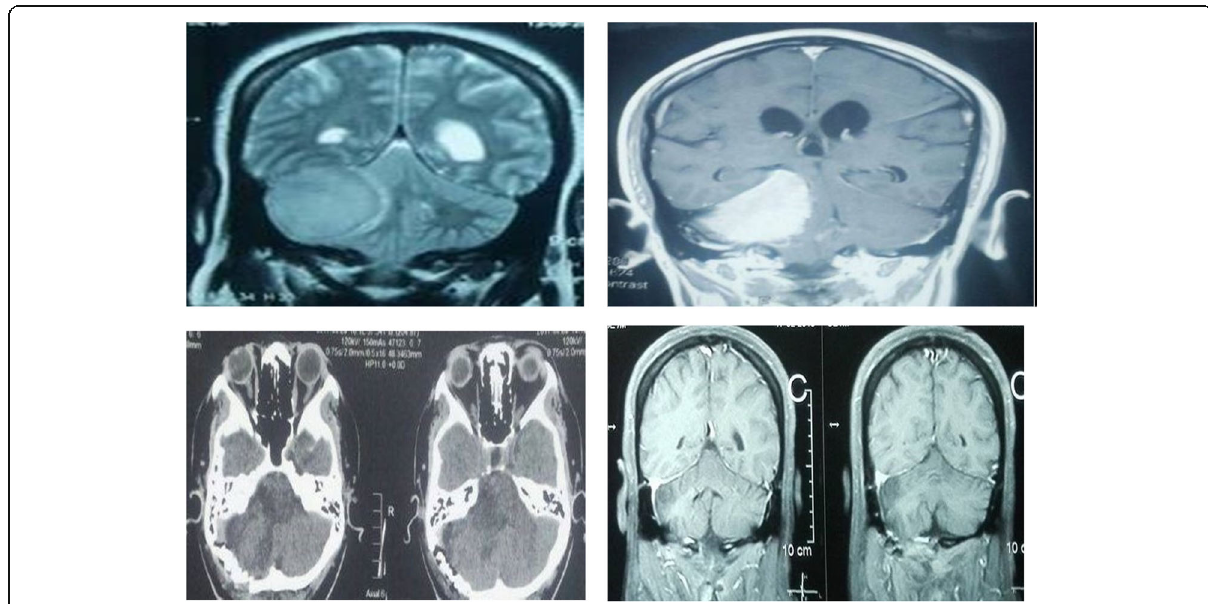
Fig. 5 Right petroclival meningioma removed by right retrosigmoid approach. Upper left, coronal TII MRI image showing giant lesion. Upper right, coronal MRI brain with contrast showing homogeneous contrast enhancement. Lower left, axial CT brain done 1 day postoperative showing total removal. Lower right, coronal MRI brain with contrast done 1 year after surgery showing total removal with